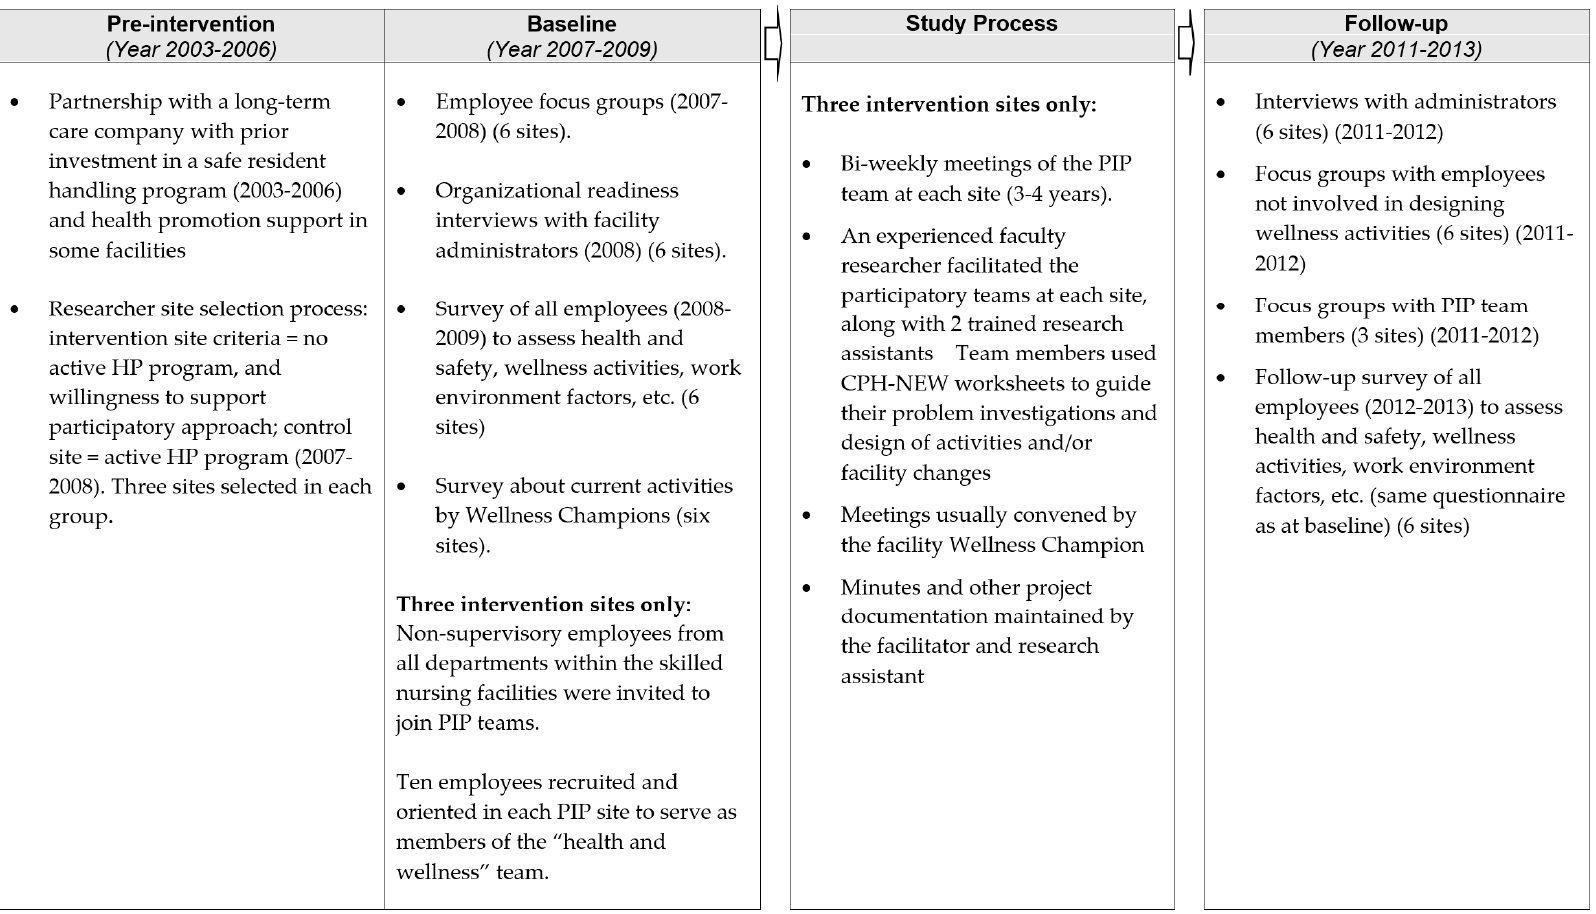
Figure 1. Timeline of the participatory intervention process and impact evaluation. HP, health promotion; PIP, participatory intervention program; CPH-NEW, Center for the Promotion of Health in the New England Workplace.